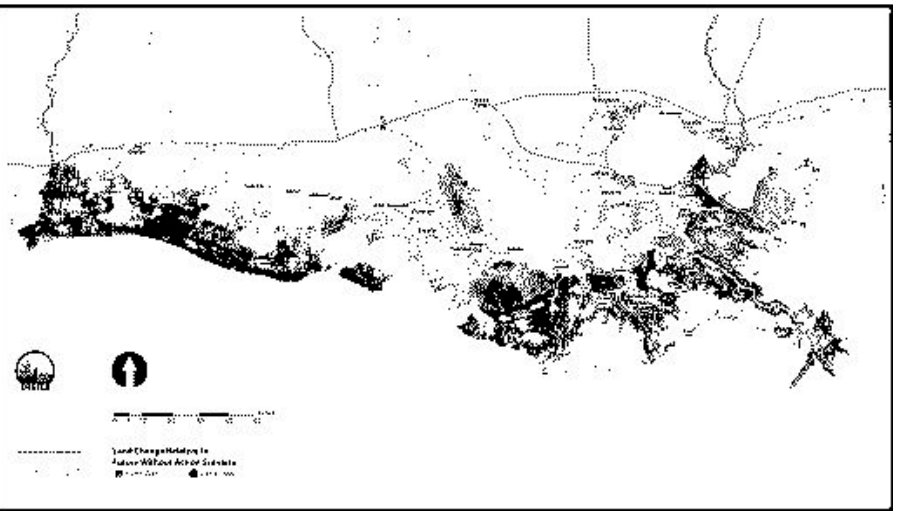
Fig. 1 Land change relative to future without action (2012 Louisiana Coastal Master